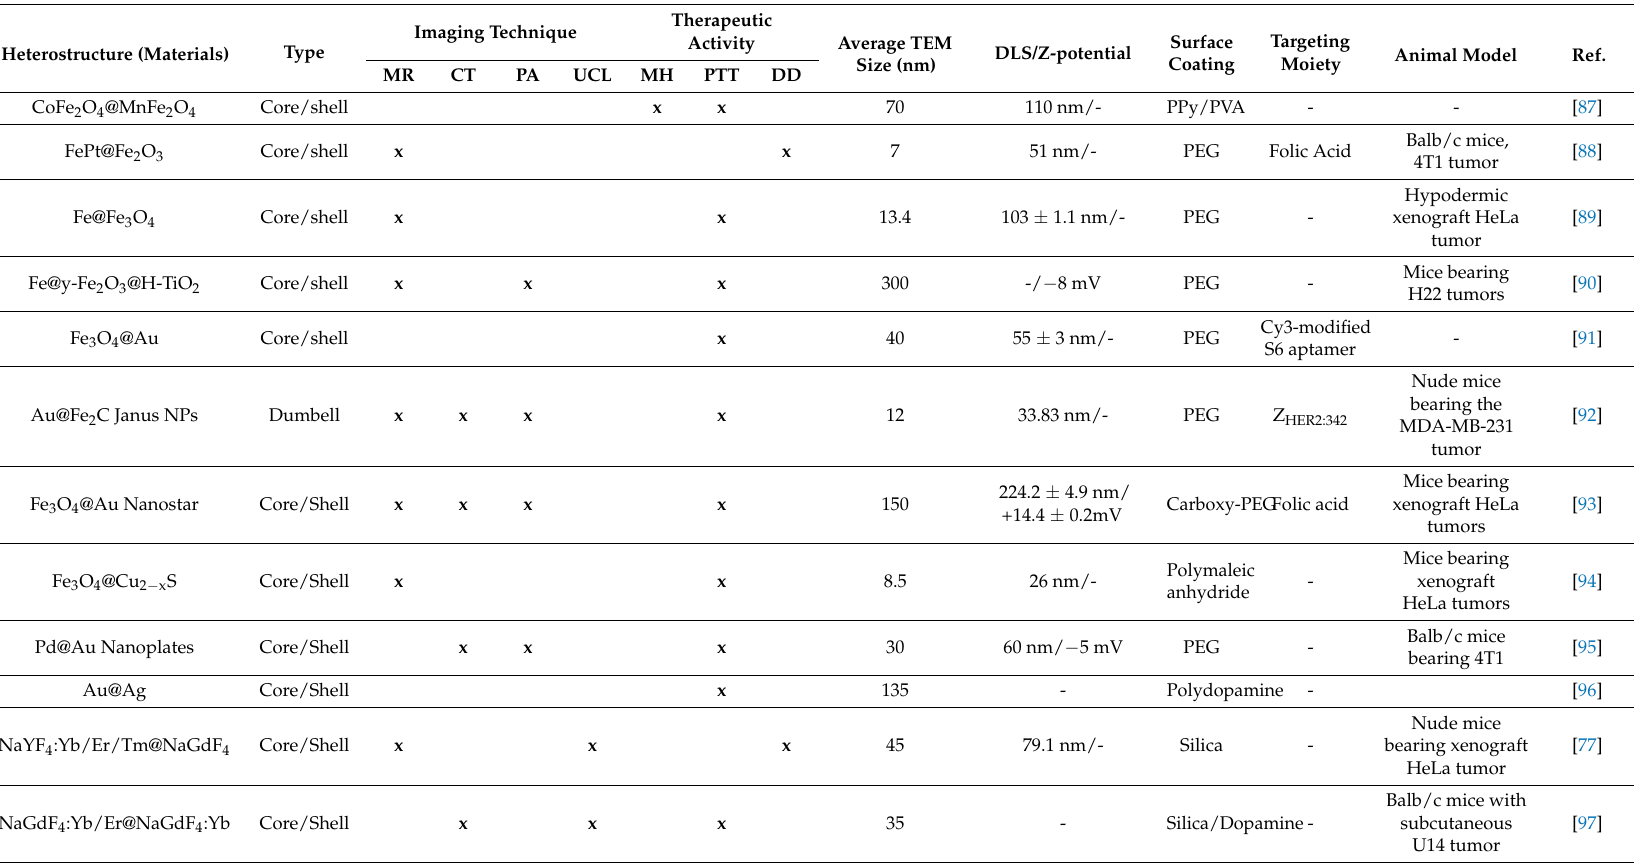
Table 2. Summary of nanoheterostructures applied in therapy and/or